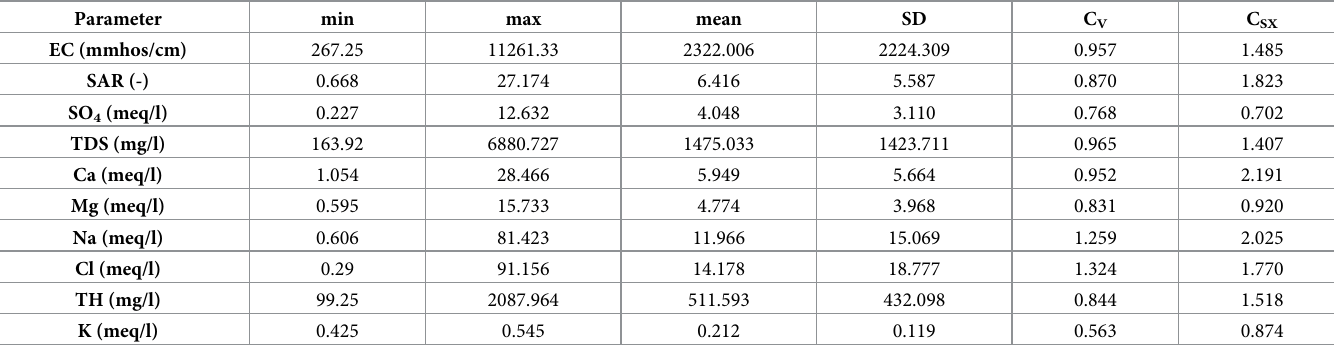
Table 1. Statistical characteristics of the utilized groundwater quality parameters.